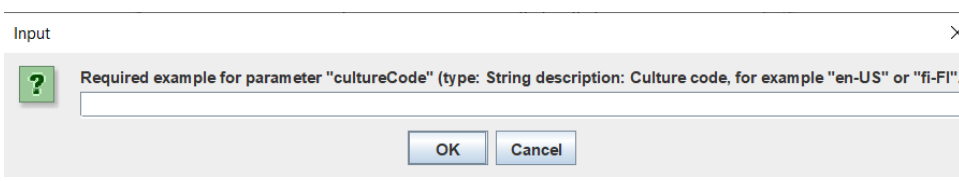
Figure 4. Descriptive values for API parameters.